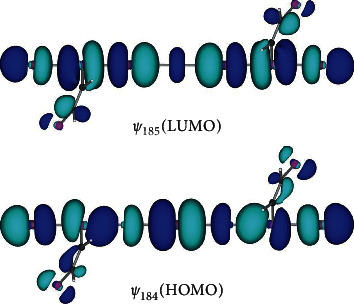
Molecular orbitals for σ(7c–10e). ψ184 (HOMO) and ψ185 (LUMO) of 8 (C2h).